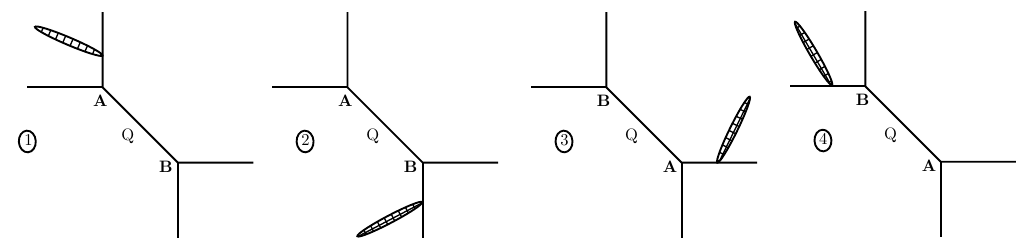
Figure 14: Branes attached to various legs of the conifold